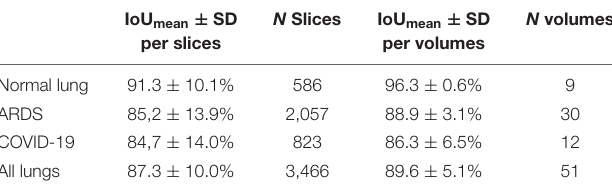
TABLE 3 | Mean Intersection over Union calculated per slices and per volumes.